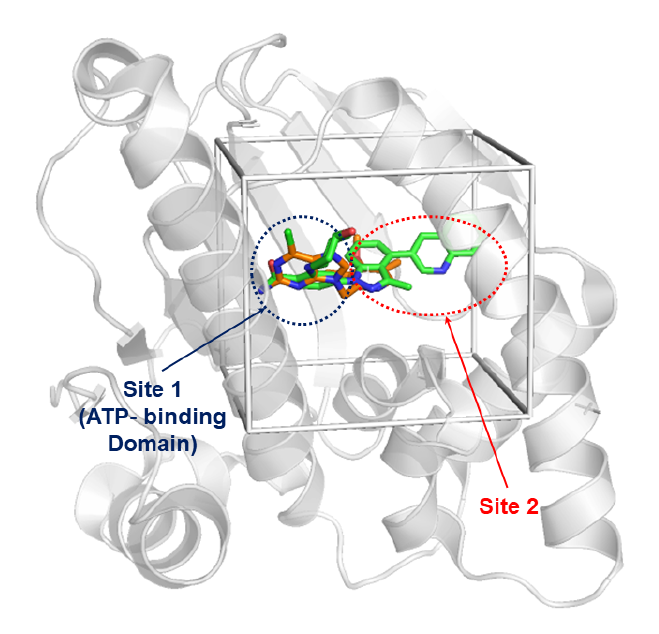
Figure 3. Hsp90 co-crystalized (PDB ID: 5LQ9) with ligand in green, and superposition of BIIB021 purine derivative compound in